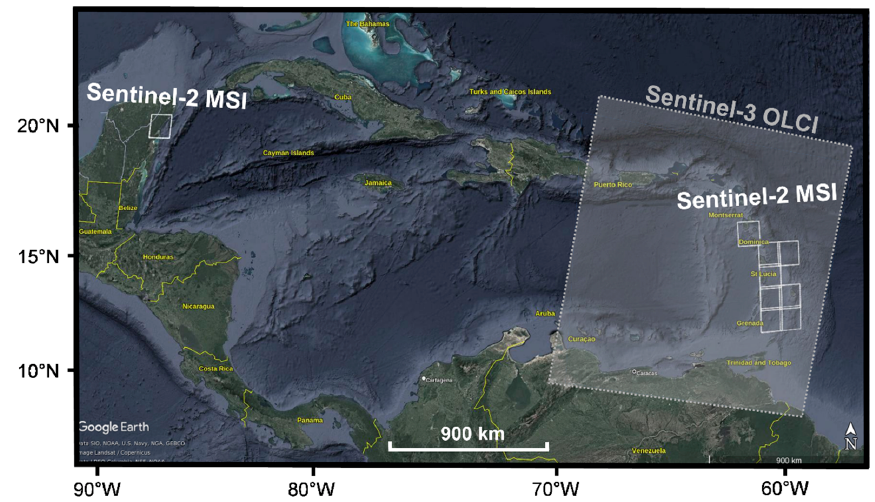
Figure 1. Location of Sentinel-3 OLCI images (white dotted boxes) and Sentinel-2 MSI tiles (white boxes) used for the learning and focus sets. Table 1. Images of the focus dataset used to evaluate the performance of our CNNs compared to images from the literature, with a summary of their characteristics: location, acquisition date and time, satellite, and sensor. The ‘Source’ column indicates the source of each image: a reference for images taken from the literature, and ‘us’ for images processed with our own CNN method.